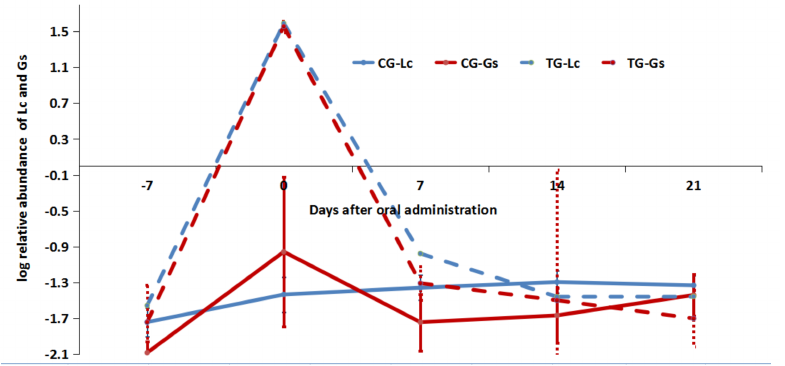
Figure 5. The changes in relative abundance of Lc and Gs in the CG and TG from day − 7 to 21. The relative abundance of Gs had the same trend as that of Lc (see Figures 4 and